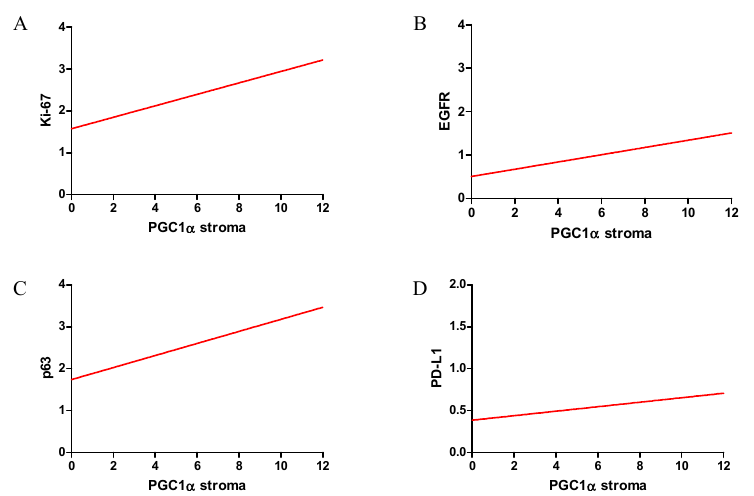
Figure 7. Correlations of PGC-1 α expression levels in stromal cells with diagnostic markers were moderate positive—Ki-67 ( A ), weak positive—EGFR ( B ), weak positive—p63 ( C ) and weak positive— PD-L1 ( D ) in NSCLC (n = 860).